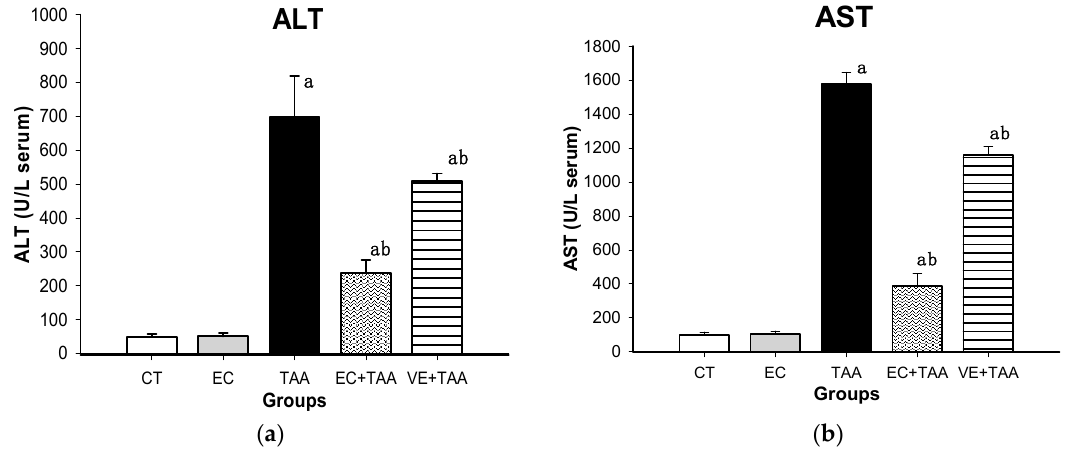
Figure 2. Effect of EC pretreatment on levels of ( A ) ALT and ( B ) AST analyzed by Wiener Lab equipment in the serum of rats intoxicated with a sublethal dose of thioacetamide (TAA). All data are expressed in U/L. Bars indicate the mean value with SE of two determinations (n = 8). The differences compared with the vehicle are expressed as “ a ”; while the differences due to TAA are expressed as “ b ”, p ≤ 0.05.